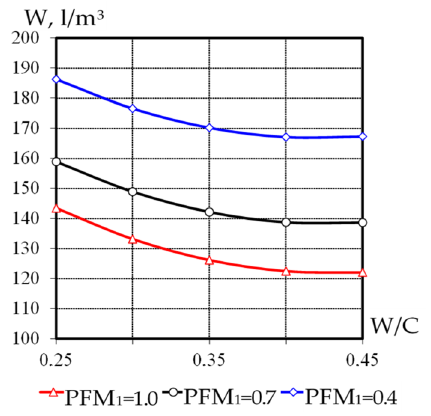
Figure 3. The influence of W/C and PFM 1 additives on the concrete mixture water consumption (S ssa = 450 m 2 /kg, Sl = 13 cm).